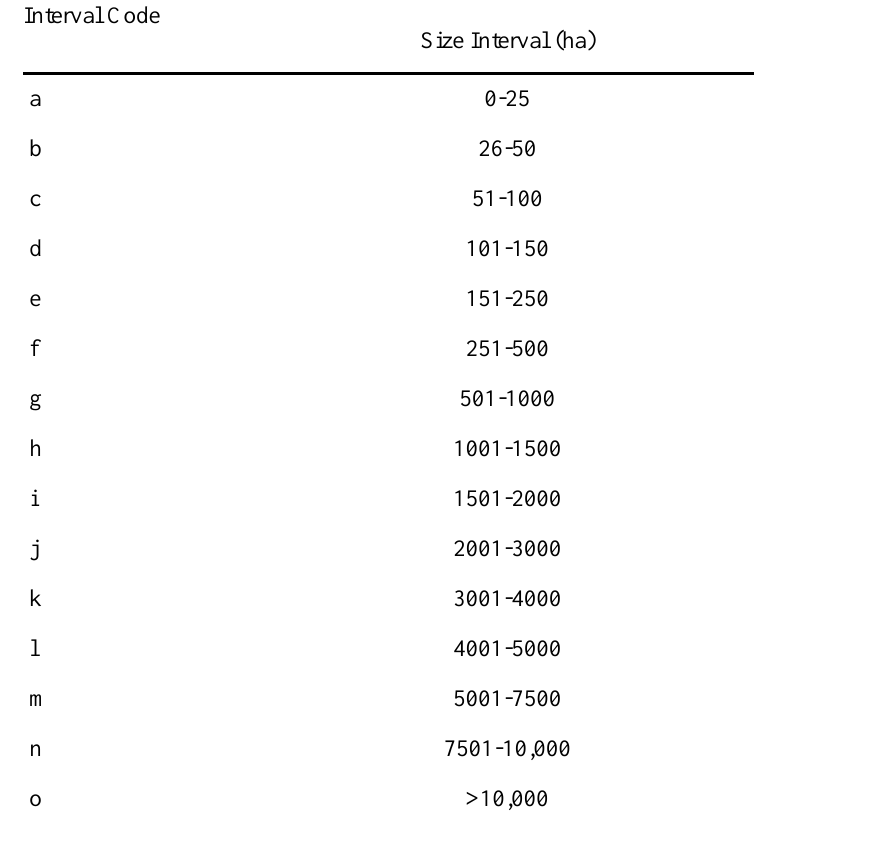
Table 1. Classification of land ownership data by parcel